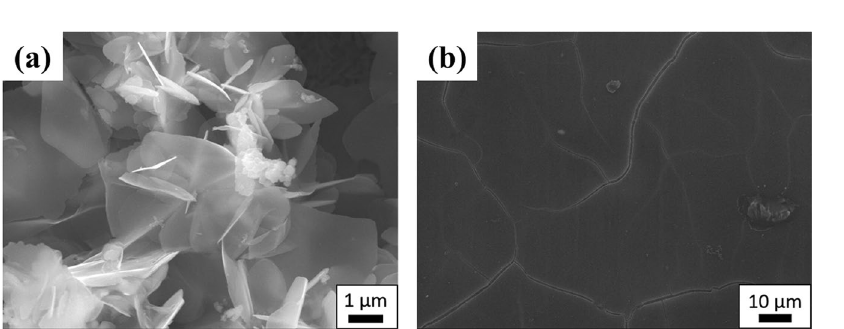
Figure 2. SEM image of the Fe sample after corrosion for 24 hours. (a) The corroded site of Fe. (b) The anticorrosion site of